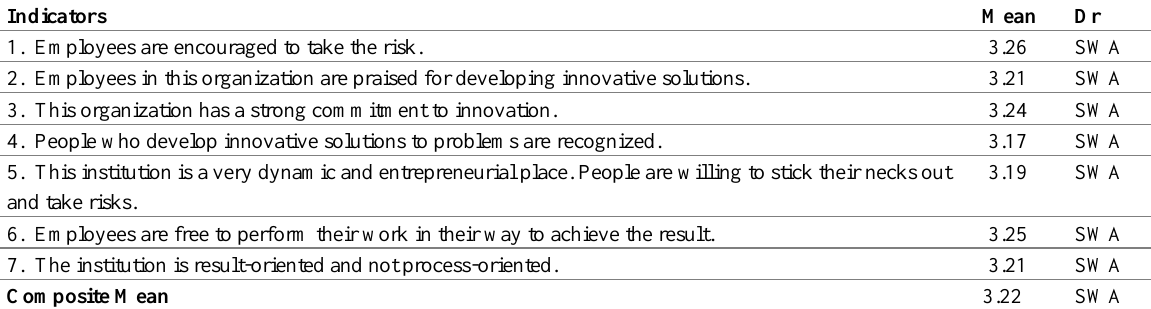
Table 5: The Work Environment of the Divine Word Colleges in the Ilocos Region in terms of Entrepreneurial Environment Indicators